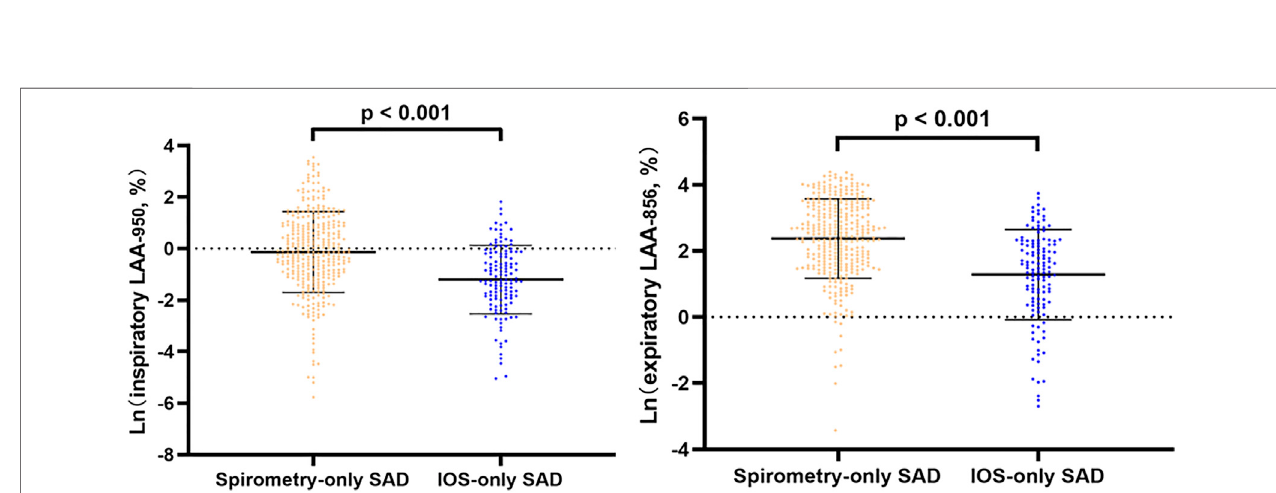
FIGURE 2 | Line regression analysis of CT-emphysema and gas trapping difference between IOS-SAD and spirometry-SAD in all subjects. Adjusted for baseline statistical difference variables (age, sex, BMI, smoking status, smoking index, cough, phlegm, treatment, and family history of respiratory disorder). Ln: natural log. 342 spirometry-SAD subjects underwent CT and 129 spirometry-SAD subjects underwent CT in all subjects. Abbreviations: IOS, impulse oscillometry; SAD, small airway dysfunction; CT, computed tomography.